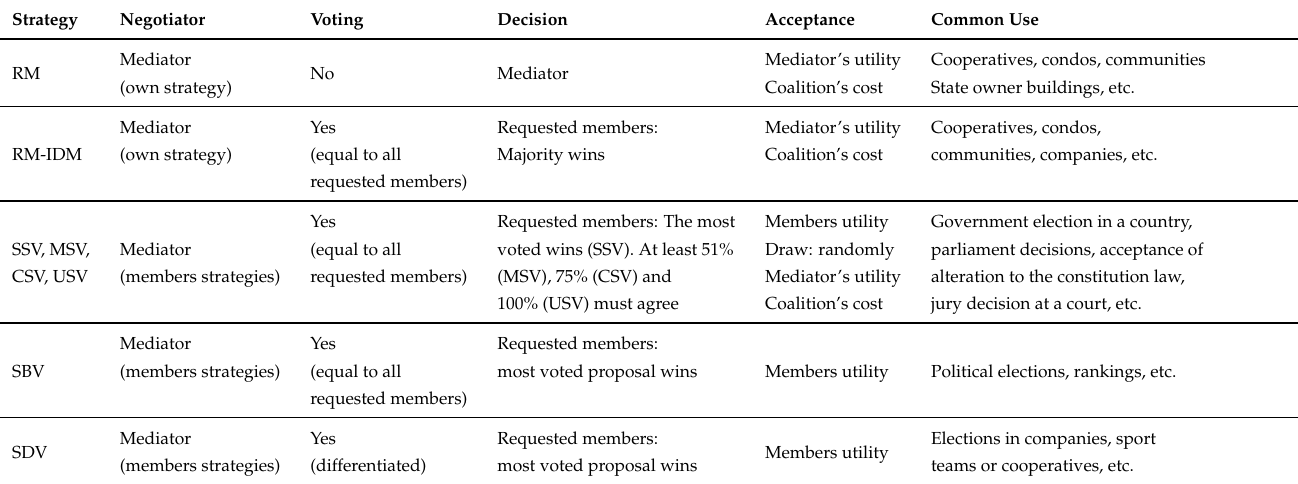
Table 3. Characteristics of the team